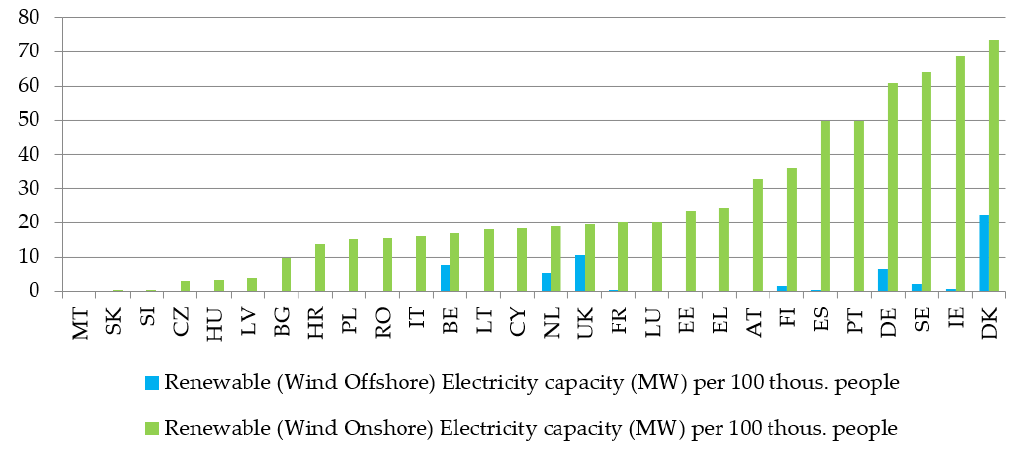
Figure 2. Renewable (wind offshore) electricity capacity (MW) per 100 thous. people and renewable (wind onshore) electricity capacity (MW) per 100 thous. people.